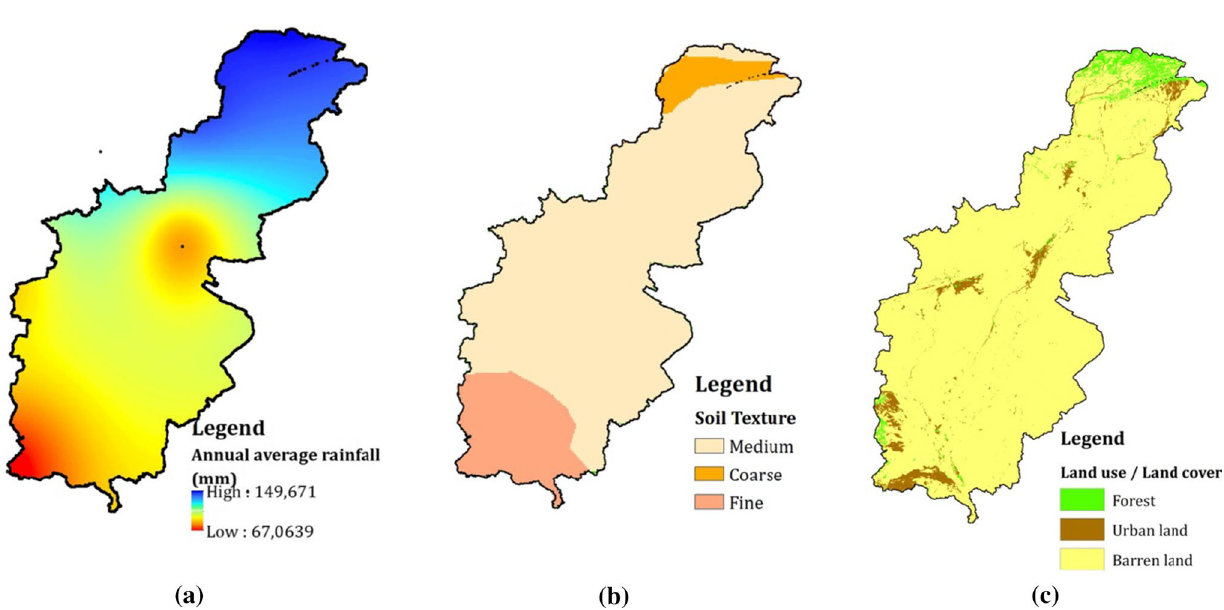
Fig. 3 soil Sensitivity to Erosion Index parameters. a Weighted average annual rainfall. map. b Soil texture map. c Soil use map/vegetal